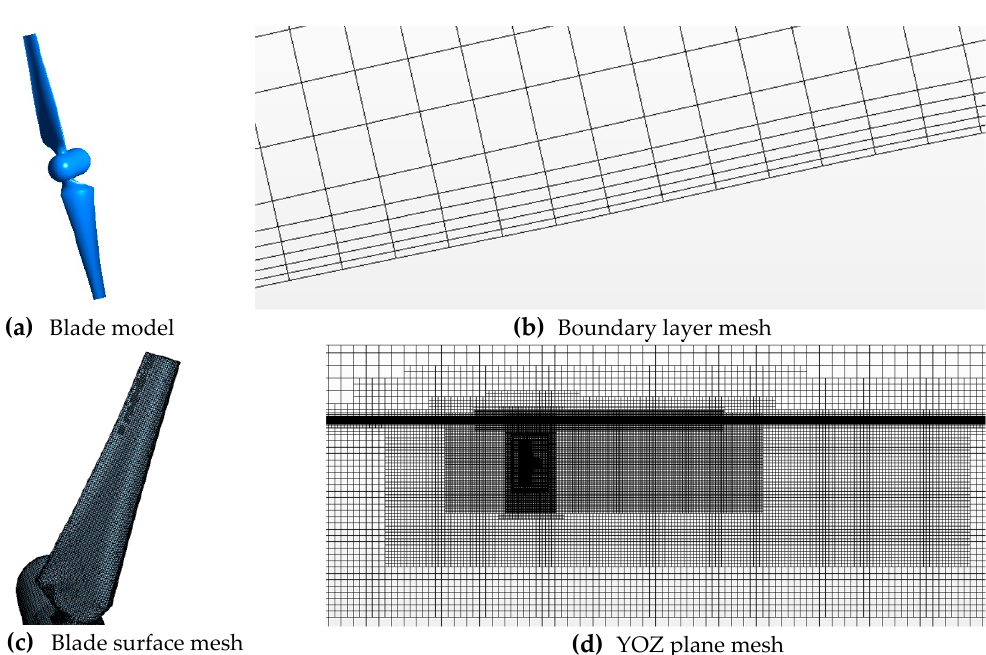
Figure 2. Schematic and mesh model.